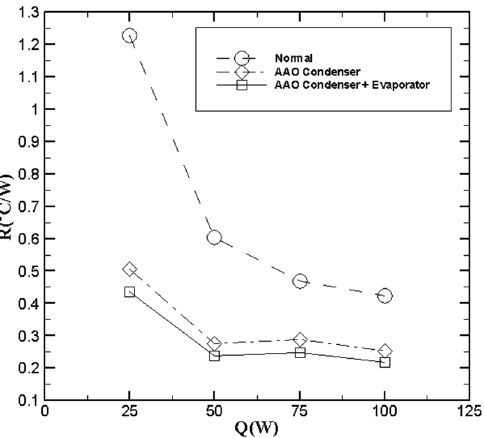
Figure 9. Variation of the overall thermal resistance with input heat power at an anodizing voltage of 50 V and a treatment time of 9 h.